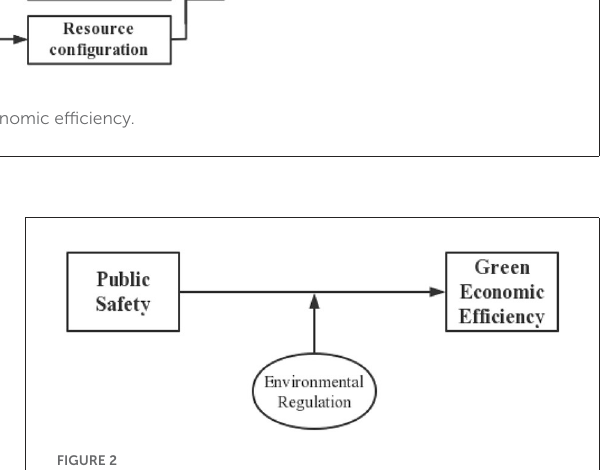
FIGURE2 The regulatory role of environmental regulation.